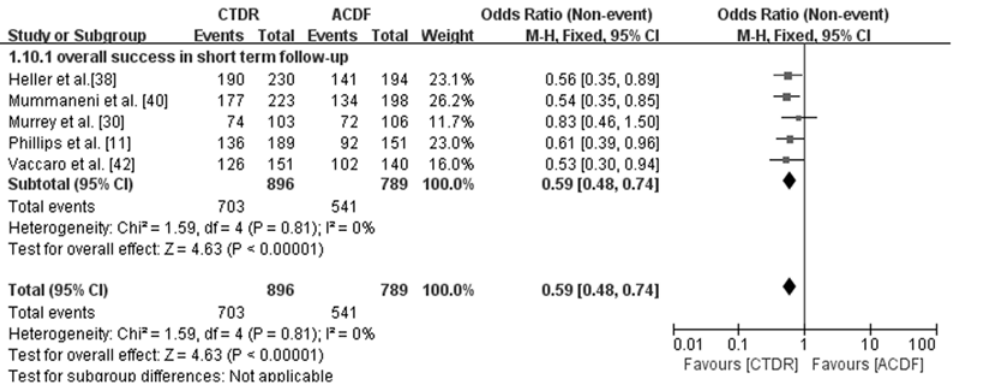
Fig 8. Comparison of overall success between the cervical total disc replacement (CTDR, experimental) group and the fusion (ACDF, control) group in short-term follow-up. MH = Mantel-Haenszel, CI = confidence interval, and df = degrees of